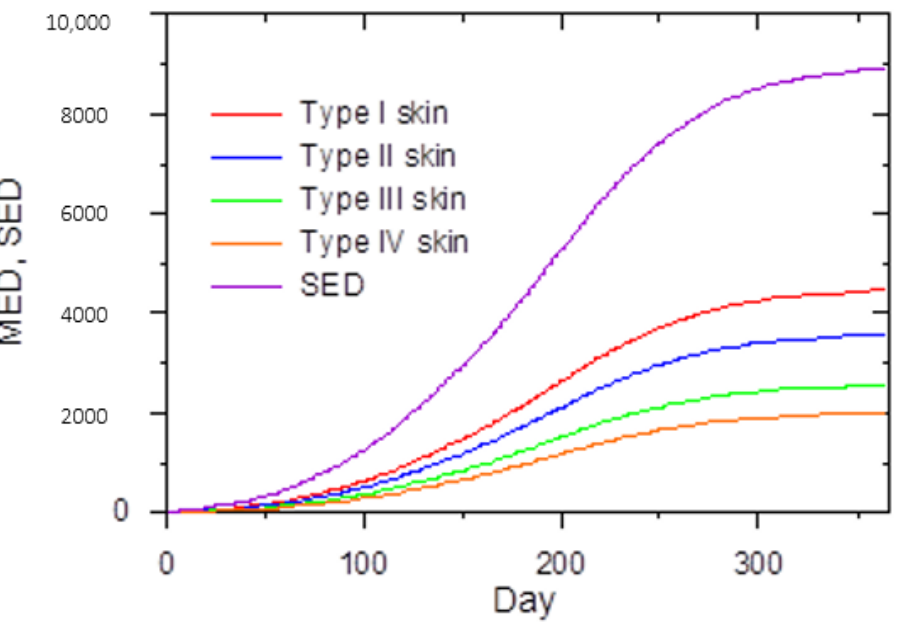
Figure 5. Yearly cumulative dose (minimum erythema dose—MED) for different skin types defined by ISO 17166 CIE S 007/E and Standard Erythemal Dose, in Valladolid, Spain, for the period 2013– 2019.